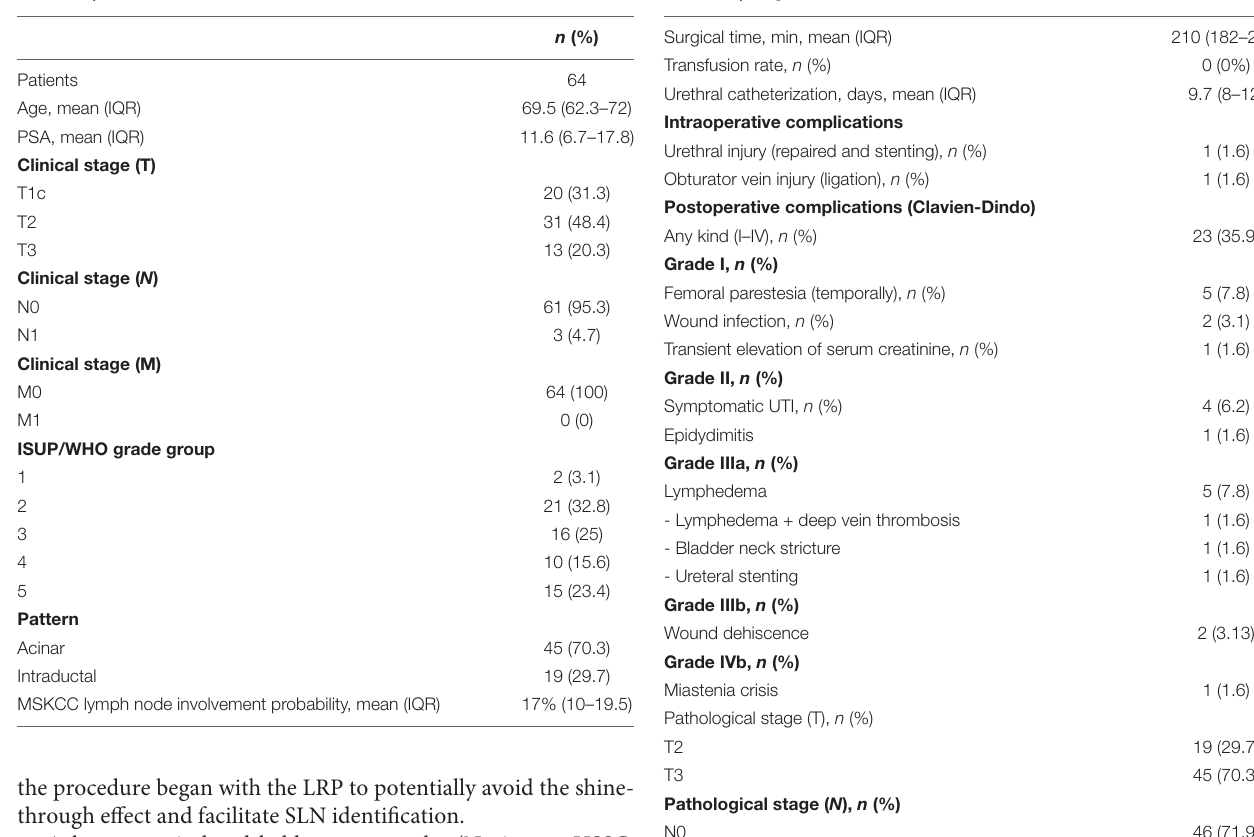
TABLE 1 | Clinical baseline characteristics. TABLE 2 | Surgical